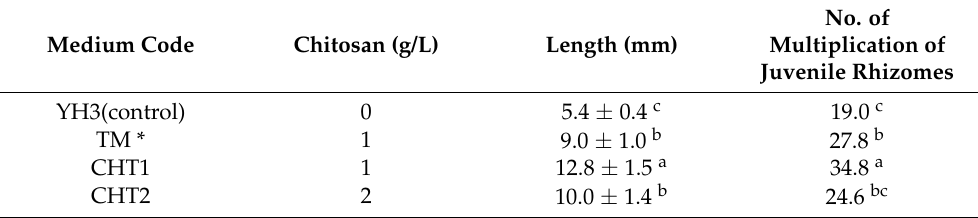
Table 3. Effect of chitosan concentration on growth and proliferation of G. elata juvenile rhizomes in culture medium for 8 weeks. Medium Code Chitosan (g/L) Length (mm)